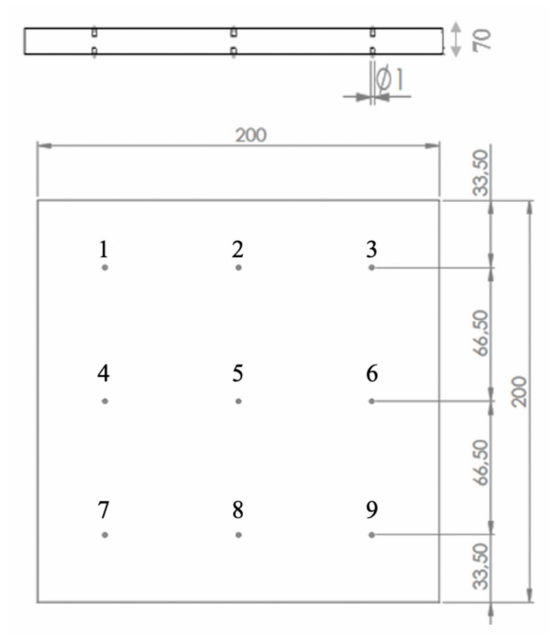
Figure 5. Thermal zones locations on the cob